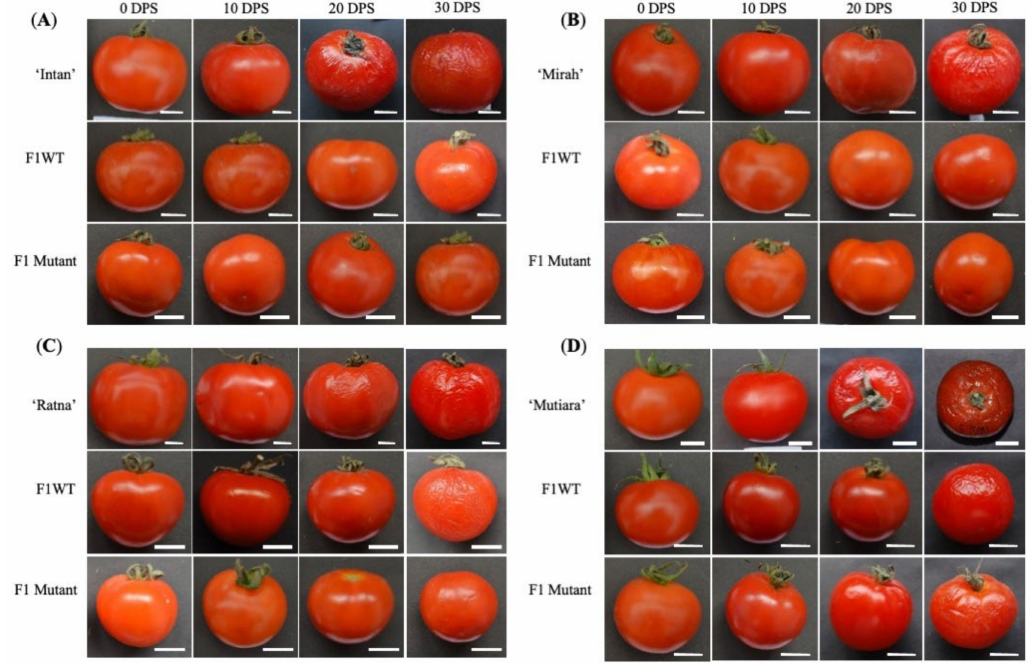
Figure 3. Fruit phenotypes of ( A ) ‘Intan’, ‘Intan’ × ‘WT’, and ‘Intan’ × Sletr1-2 ; ( B ) ‘Mirah’, ‘Mirah’ × ‘WT’, and ‘Mirah’ × Sletr1-2 ; ( C ) ‘Ratna’, ‘Ratna’ × ‘WT’, and ‘Ratna’ × Sletr1-2 ; ( D ) ‘Mutiara’, ‘Mutiara’ × ‘WT’, and ‘Mutiara’ × Sletr1-2 ; during the fruit shelf-life evaluation. The fruits were stored for 30 days under room temperature conditions at ± 22 ◦ C and ± 77% humidity. Scale bars = 1